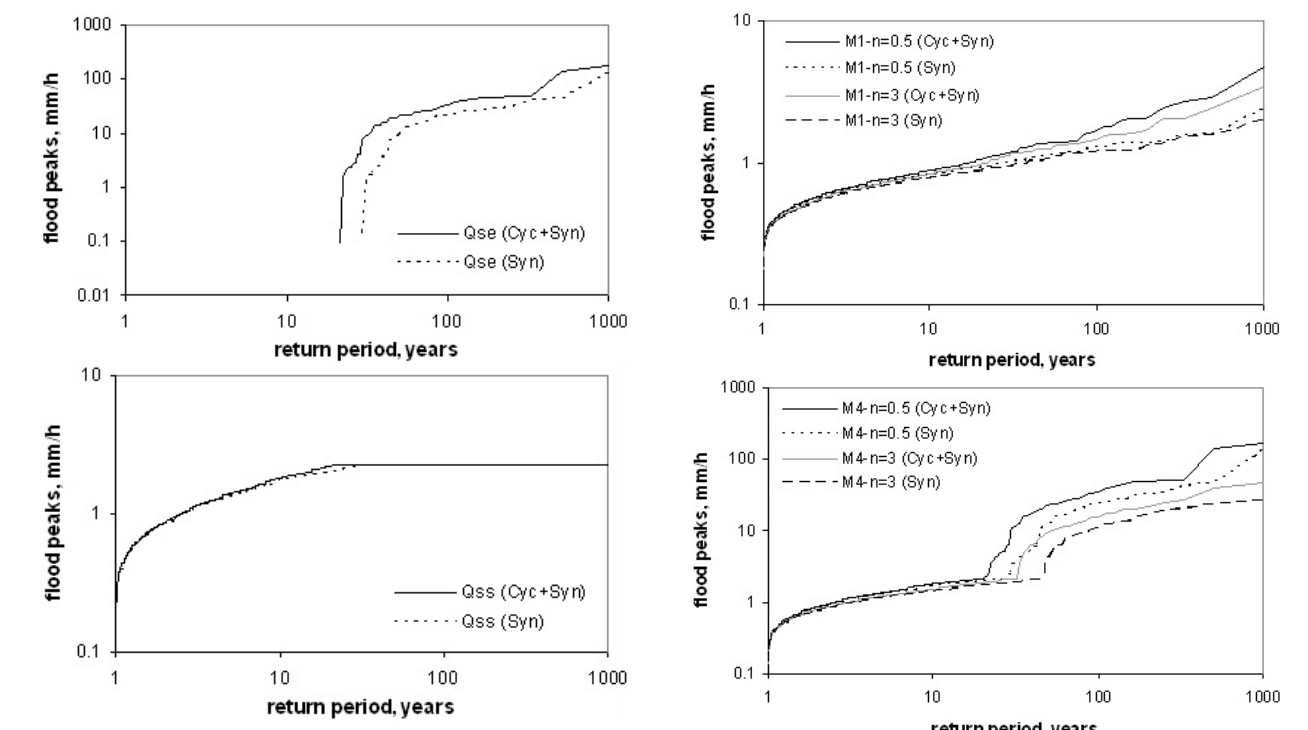
Fig. 11. Flood frequency curves generated by (a) Model 1 and (b) Model 4 using synoptic events only (Syn) and synoptic and cyclonic events (Cyc+Syn) for S b =150mm, η =0.5 and η